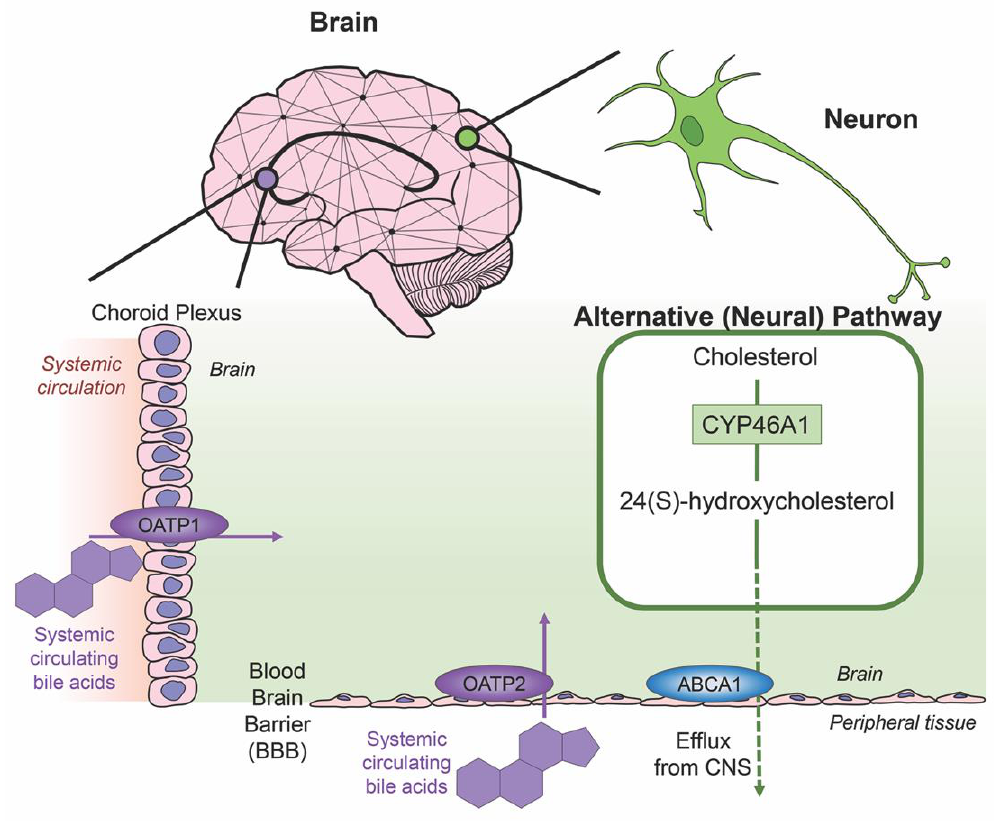
Figure 3. Neural cholesterol clearance pathway and bile acid transport into the CNS. Cholesterol is catalyzed in the brain via sterol 24-hydroxylase (CYP46A1), an enzyme expressed only in neurons. It is converted to 24(S)-hydroxycholesterol and is able to be removed from the CNS through the blood brain barrier (BBB) via the transporter ATP-binding cassette transporter 1 (ABCA1), indicated via green arrow. Other transporters mediate systemic circulating bile acids into the CNS. Organic anion transporter polypeptide 1 (OATP1) expressed in the choroid plexus and organic anion transporter polypeptide 2 (OATP2) expressed at the BBB both mediate the transport of bile acids, both processes indicated by purple arrows.